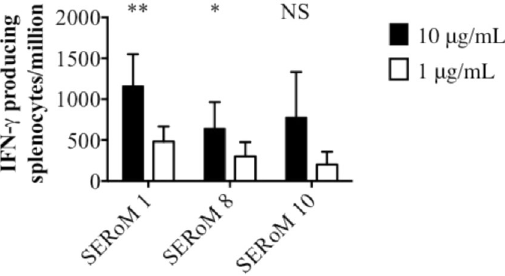
Figure 3. Immunogenicity of SERoM vaccines in C57BL/6 mice as measured by number of IFN- γ producing splenocytes. Mice (n = 3) were vaccinated subcutaneously three times with SERoM vaccines. Mean number of IFN- γ producing splenocytes per million cells, corrected for background (media only) is shown together with SD. Significance was calculated compared to relevant adjuvant vaccinated control via multiple unpaired, two tailed t-tests. * p < 0.05, ** p < 0.01. Results representative of duplicate experiments.